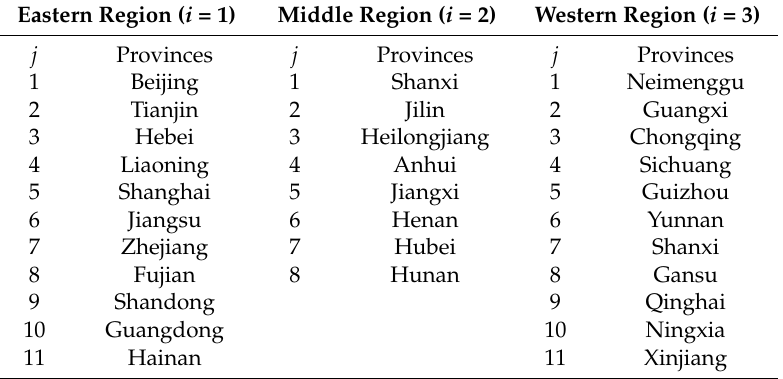
Table 1. Groupings of China’s